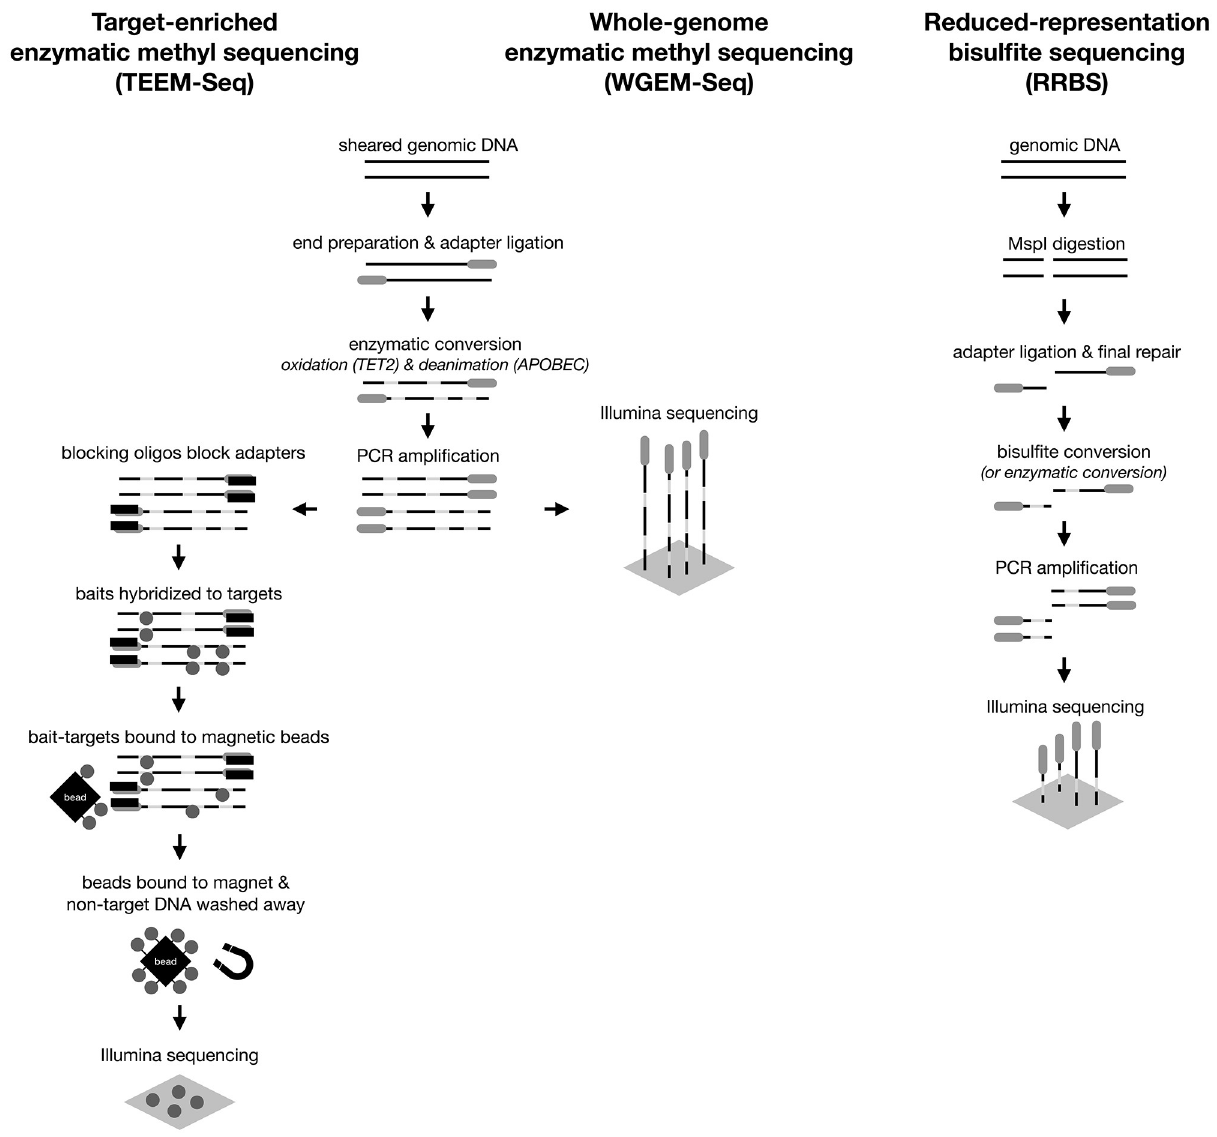
Fig 1. Diagram comparing the workflow for target-enriched enzymatic methyl sequencing (TEEM-Seq), whole-genome enzymatic methyl sequencing (WGEM-Seq), and reduced-representation bisulfite sequencing (RRBS).